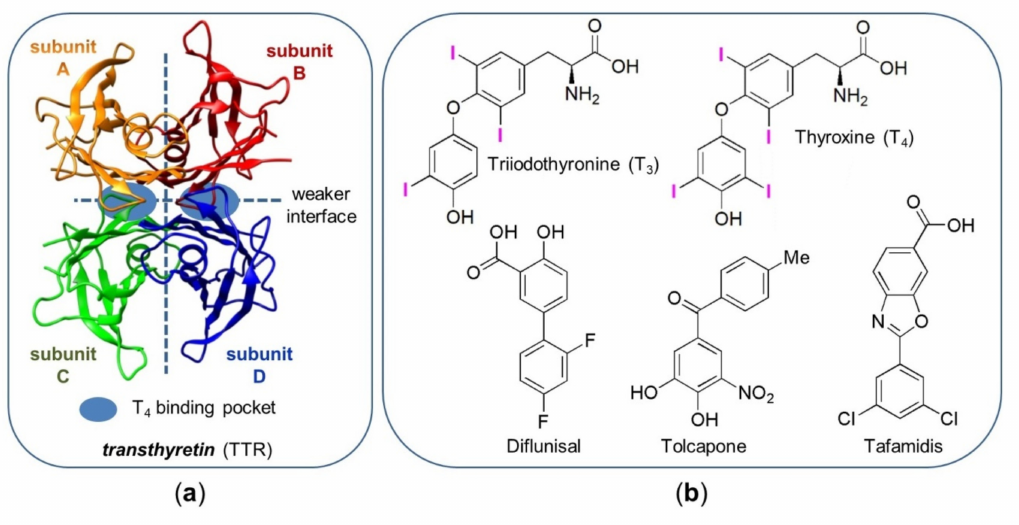
Figure 1. ( a ) Ribbon diagram picture of wild type (WT)-TTR (released from PDB ID 1ICT [2]); ( b ) structures of thyroxine (T 4 ), triiodothyronine (T 3 ), tafamidis and other ATTR drug candidates under clinical